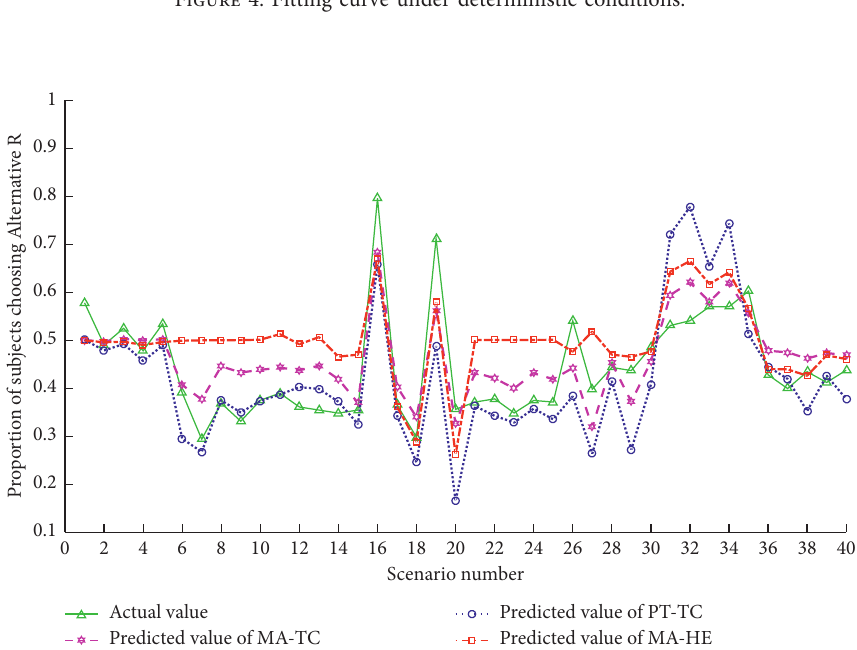
Figure 5: Fitting curve under risky